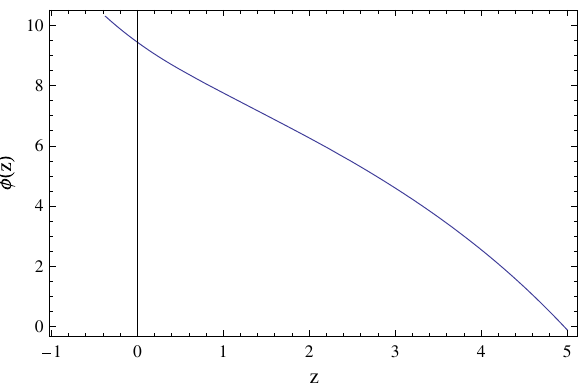
plotted the contours of ( w 0 , w 1 ) in Fig. 1 for different confidence levels 66% (solid, blue), 90% (dashed, red) and 99% (dashed, black). Now taking best fit values of the parameters w 0 and w 1 , we have drawn the Hubble parameter H ( z ) vs redshift z in Fig. 2 and the decelera- tion parameter q ( z ) vs z in Fig. 3. We have seen that the Hubble parameter and deceleration parameter decrease over the expansion of time. The deceleration parame- ter q ( z ) has a sign flip from positive to negative, so our model generates deceleration phase to acceleration phase of the Universe. Also at the present value of z = 0, the